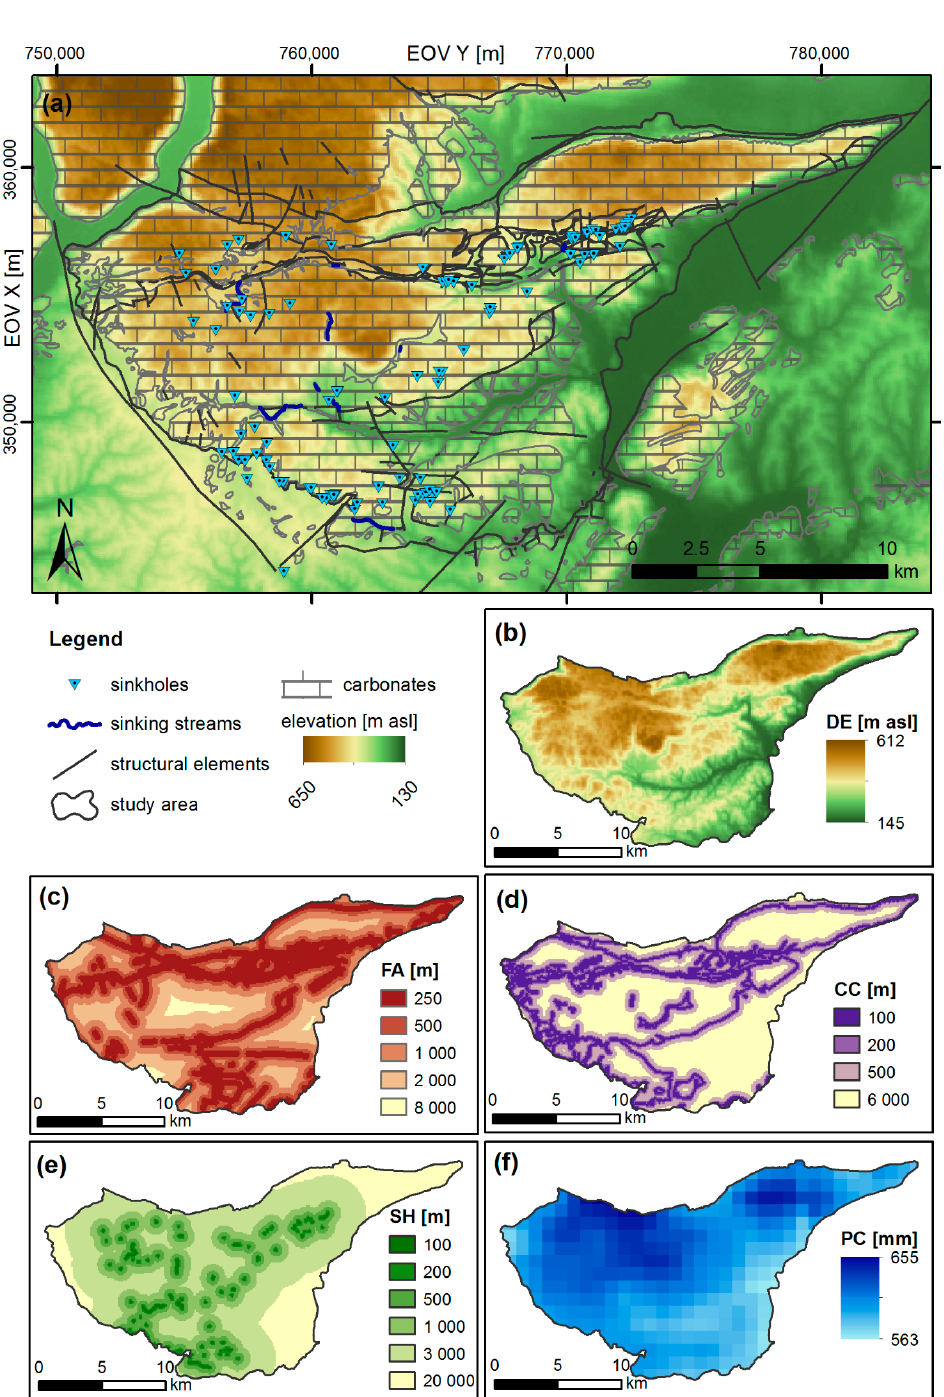
Figure 3. Creation of evidential themes ( a ) Map of base data in Table 2 used for the evidential themes, ( b ) DE: elevation, ( c ) FA: distance to faults, ( d ) CC: distance to the carbonate–non-carbonate rock contact, ( e ) SH: distance to sinkholes and sinking streams and ( f ) PC: precipitation.